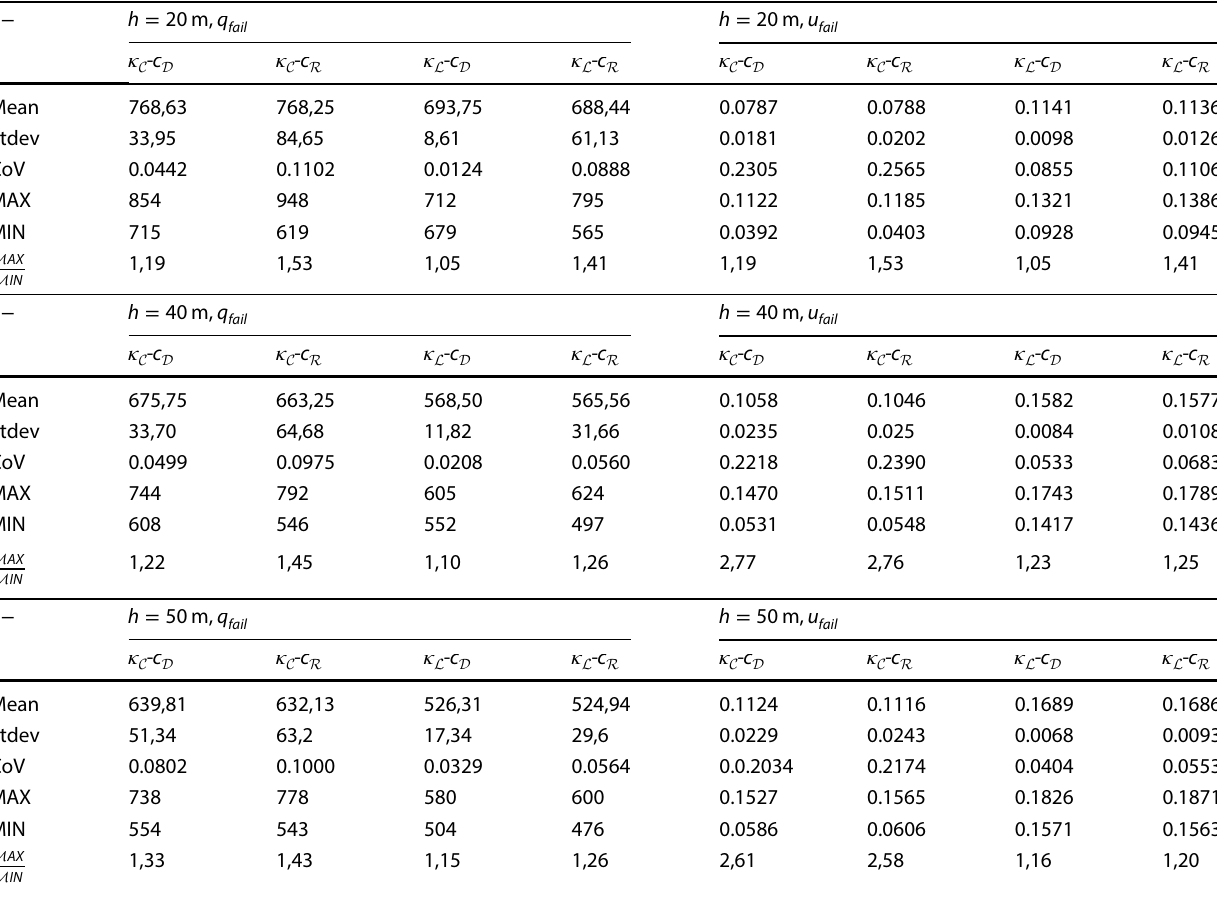
Table 5 Monte Carlo results for the failure load (KPa) (left) and displacement (m) (right) for non-porous